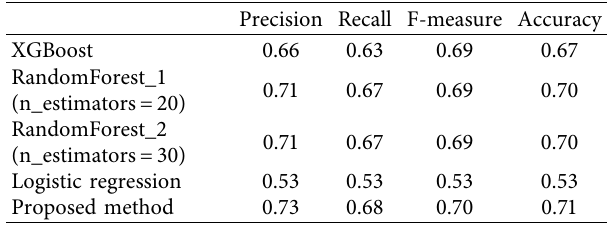
Table 5: Result for class 1 in INF dataset. Table 6: Result for class 1 in CEG dataset.